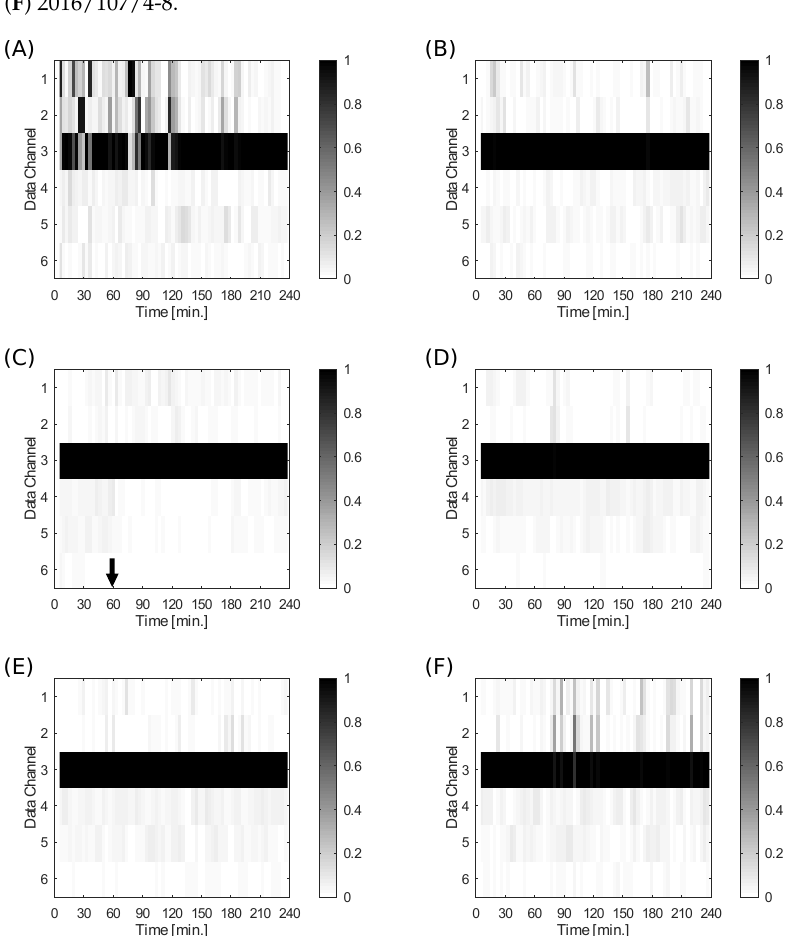
Figure 10. Transition of the eigenstate around the Fukushima earthquake for ( A ) 2016/326/12- 16, ( B ) 2016/326/16-20, ( C ) 2016/326/20-24, ( D ) 2016/327/00-04, ( E ) 2016/327/04-08, ( F )